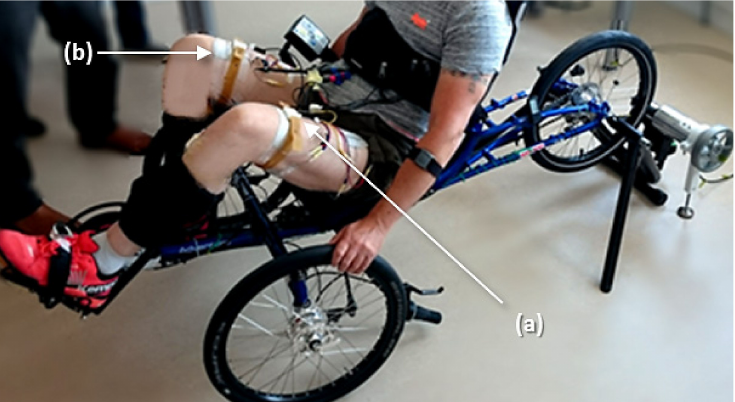
Figure 3. Home trainer cycling. The participant was installed on a recumbent trike and was equipped with 2 IMUs ( a ) connected to the controller and 2 pairs of surface electrodes ( b ) connected to the electrical stimulator. An instrumented home trainer enabled to measure the power